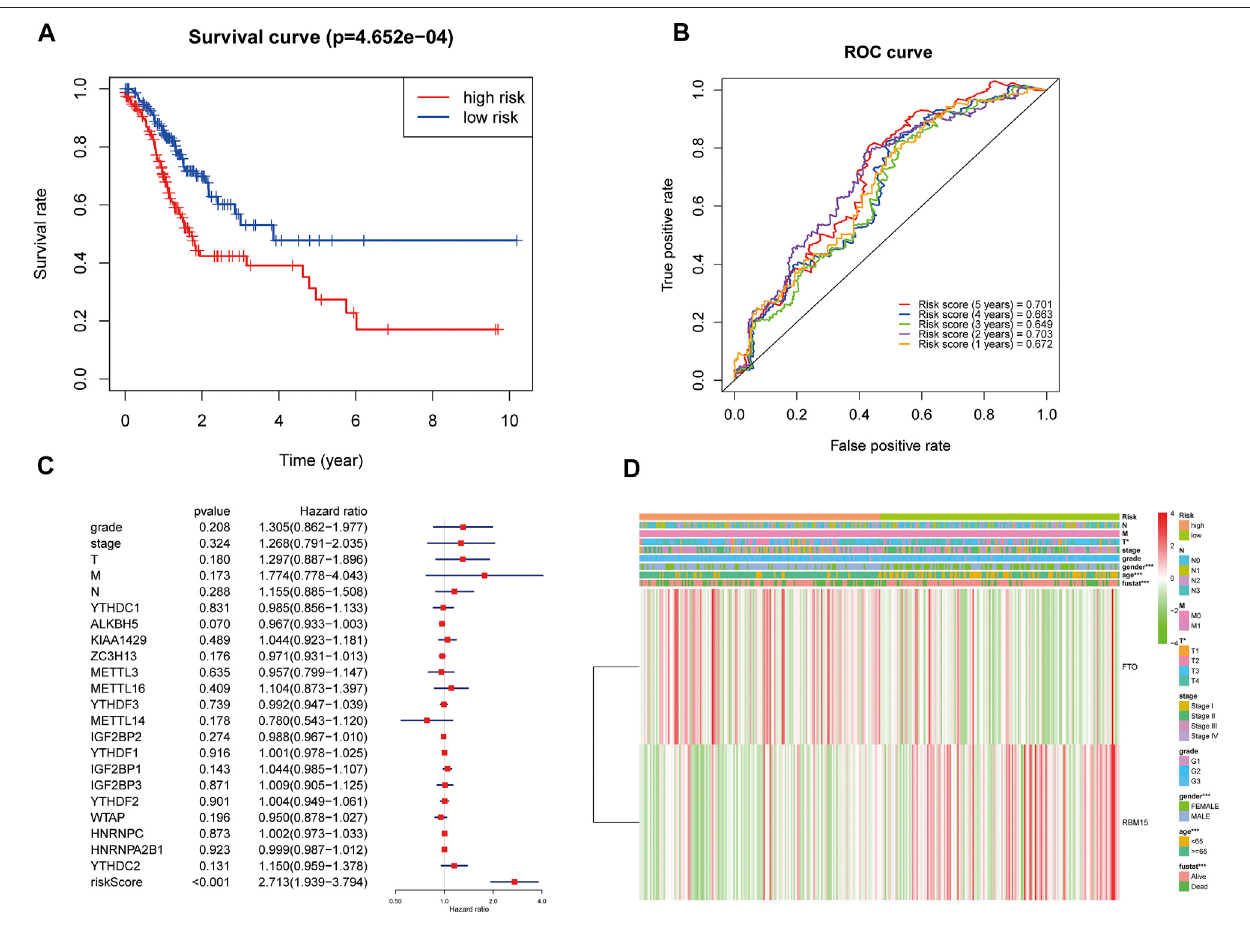
FIGURE 4 | Relationship between the risk score, clinical characteristics, and cluster subgroups. (A) Kaplan – Meier overall survival curves for patients in the TCGA database assigned to high- and low-risk groups based on the median risk score. (B) ROC curves showing the predictive ef fi ciency of the risk score signature. (C) MultivariateCoxregressionanalysesoftheassociationbetweenclinicalcharacteristics(includingtheriskscore)andoverallsurvivalofGCpatientsintheTCGAdatabase. (D) Heatmap showing the expression of FTO and RBM15 in low and high risk score patients with GC. Distribution of the clinical characteristics was compared between the low- and high-risk groups. * p < 0.05 and *** p < 0.001. GC, gastric cancer.